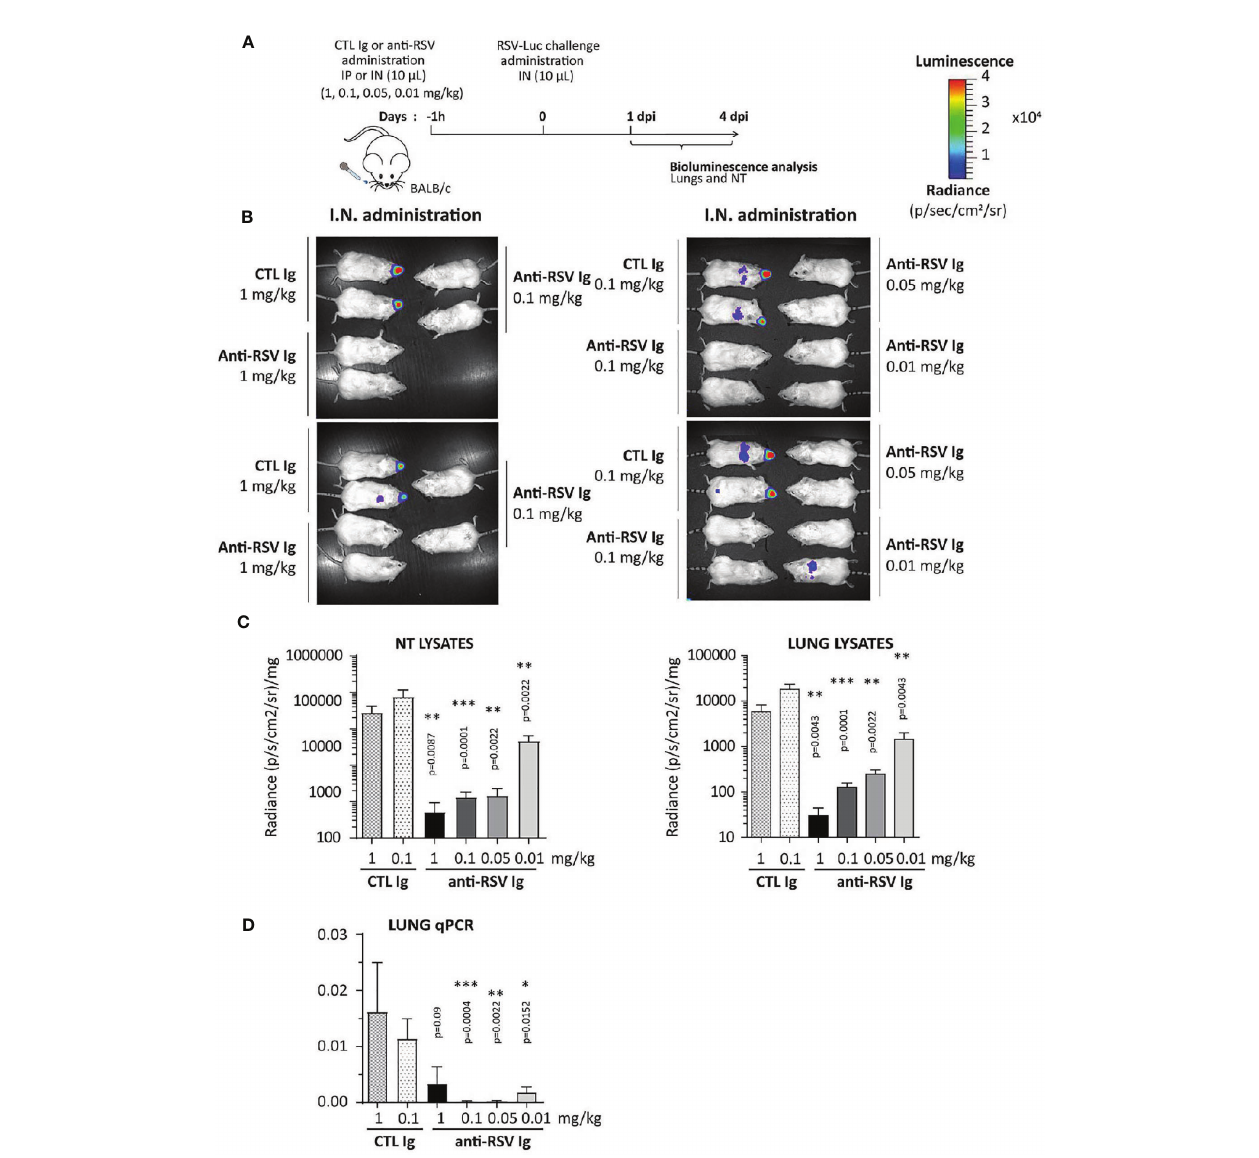
FIGURE 5 | Ef fi cacy of anti-RSV Ig intranasal administration at low doses on upper respiratory tract RSV infection in mice. (A) BALB/c mice received I.N. administration of 0.01 to 1 mg/kg of anti-RSV Ig in 10 µL one hour before I.N. injection of RSV-luciferase (1.4 x 10 5 pfu, 10 µL). As a control of RSV-Ig, mice were treated with CTL Ig (0,1 or 1 mg/kg). (B) In vivo bioluminescence intensity was evaluated at 4 d.p.i. with IVIS imaging system (dorsal view detection). Depicted images are representative of 3 independent pictures. (C) Luciferase activity was measured in NT and lung homogenates by quanti fi cation of bioluminescence emission (radiance in photon/sec/cm 2 /sr) using “ Living Image ” software after addition of luciferin in the lysates, and was normalized to the organ weight. (D) mRNA level of RSV N gene was evaluated by real time RT-PCR in the lungs and expressed with the formula (2 - D Ct ). Data are mean ± SEM from n = 6 mice for CTL Ig- treated mice or all doses of anti-RSV Ig and n = 12 for mice treated with 0.1 mg/kg of anti-RSV Ig. Signi fi cance is represented on graphs: *P < 0.05; **P < 0.01; ***P <